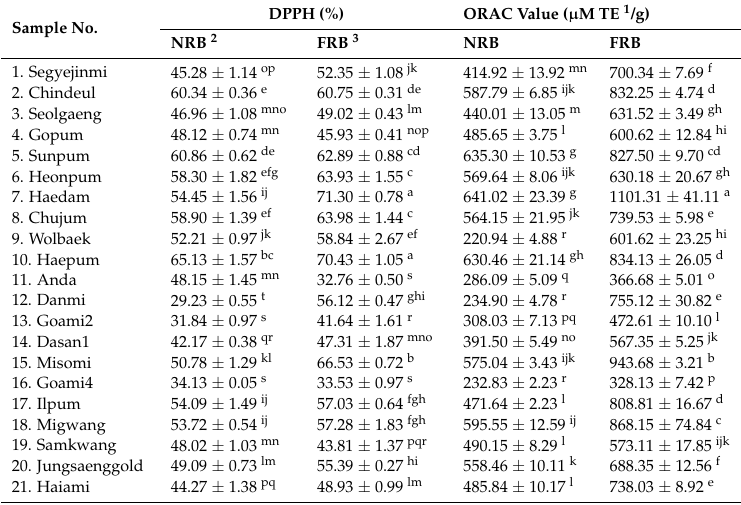
Table 4. Antioxidant activity of 21 cultivars of rice bran by bioconversion. Sample